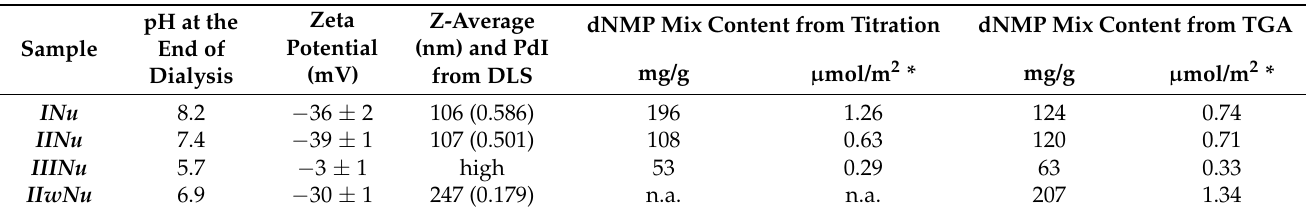
Table 3. A comparison of stability and dNMP content of NPs surface modified in ethanol and in water. INu , IINu and IIINu are samples modified using the ethanolic procedure at the age of 0, 6 and 20 days after dialysis, and the IIwNu sample is treated by the aqueous procedure, which is dialyzed into water 7 days after